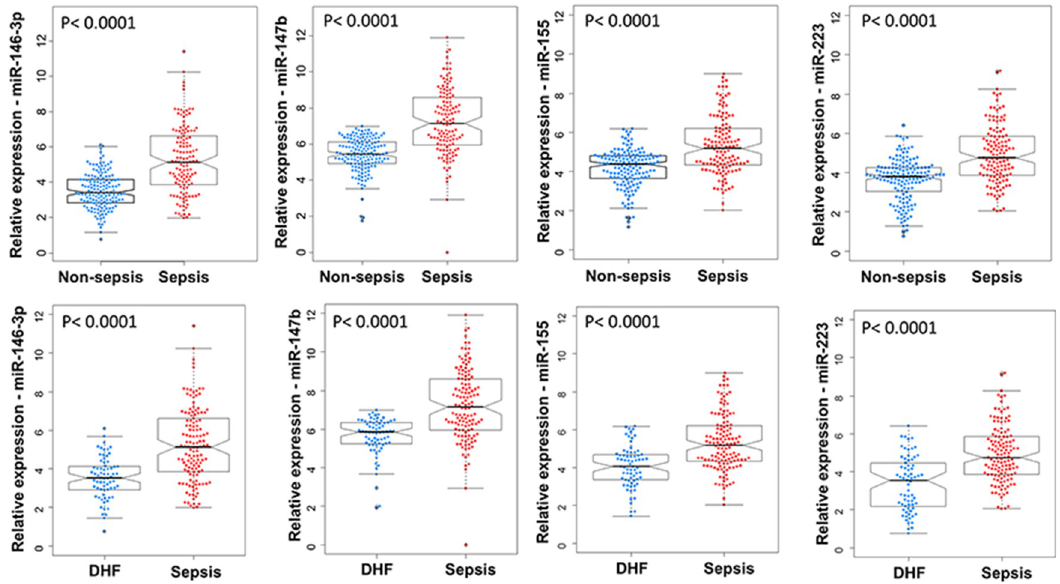
Fig 1. Expression of selected microRNAs is significantly elevated in sepsis patients compared to controls. Relative expression of individual miRNA (miR-146-3p, miR-147b, miR-155 and miR-223) in patients with and without sepsis. Non-sepsis group includes healthy controls (HC) and dengue hemorrhagic fever (DHF). P values were calculated by Wilcoxon